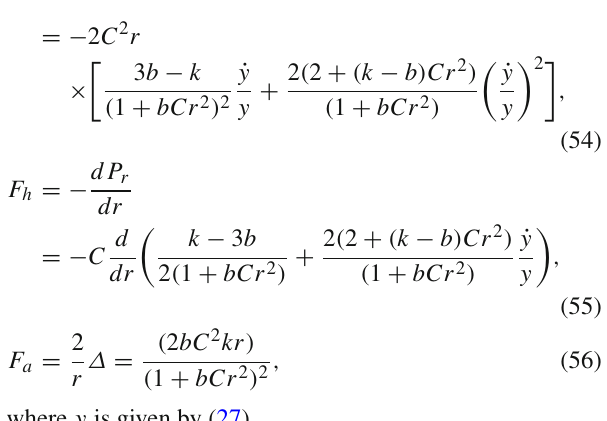
Fig. 19 Behavior of forces in Cen